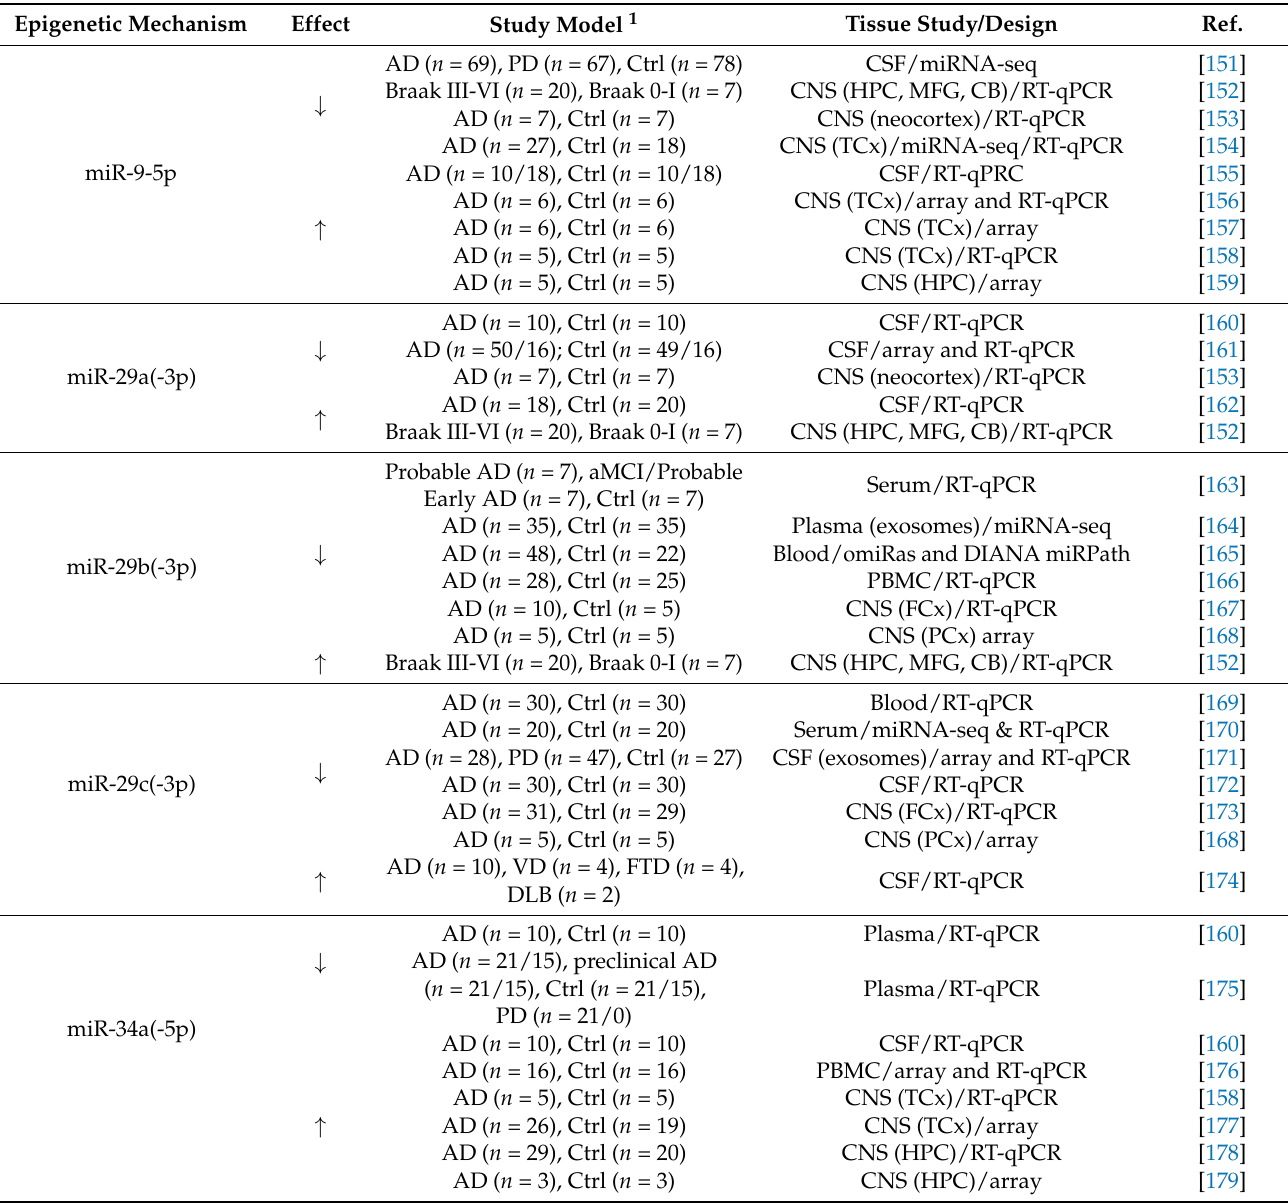
Table 4. Short overview of studies investigating miRNA expression in AD. More detailed overview is given in Supplemen- tary Materials (Table